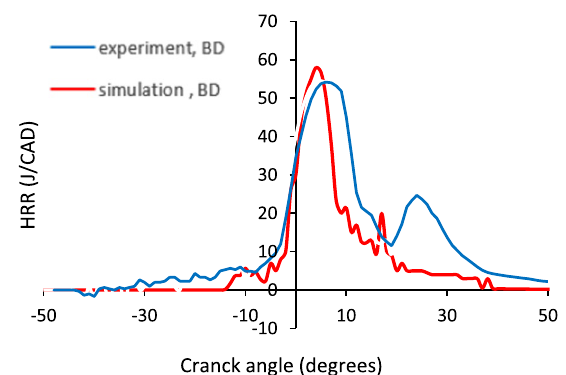
Fig. 5 Heat release rate (HRR) of base diesel fuel at 100% of engine load